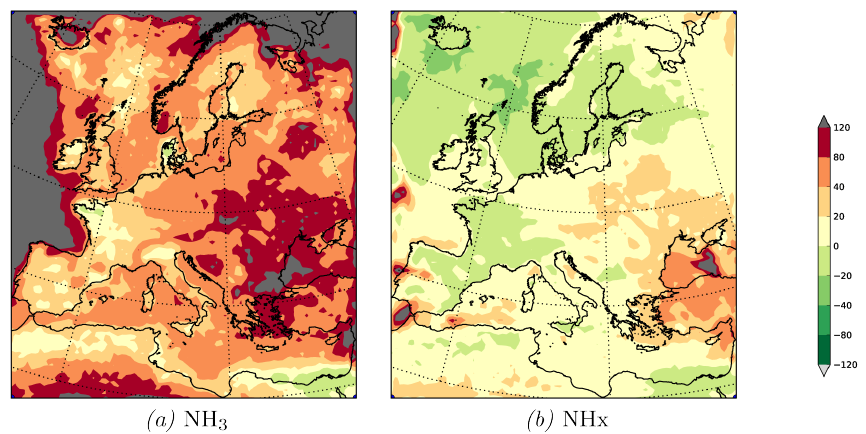
Figure 11. Changes in total deposition (%), from 2005 to 2050, for NH 3 and NH x . Results from the 3CTM ensemble. The colour scale is identical to that used for emission changes in Fig. 2.